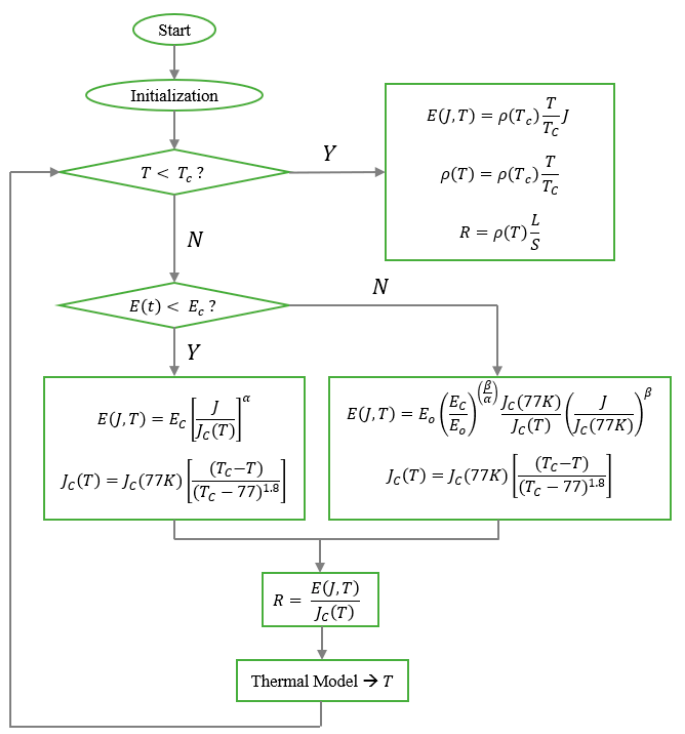
Figure 4. Magneto-Thermal model flow